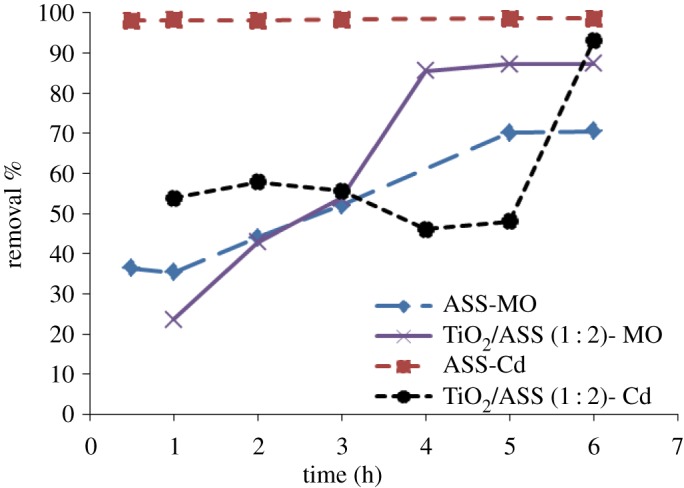
Effect of contact time on MO and Cd2
+ removal efficiency by ASS or TiO2/ASS (1 : 2).